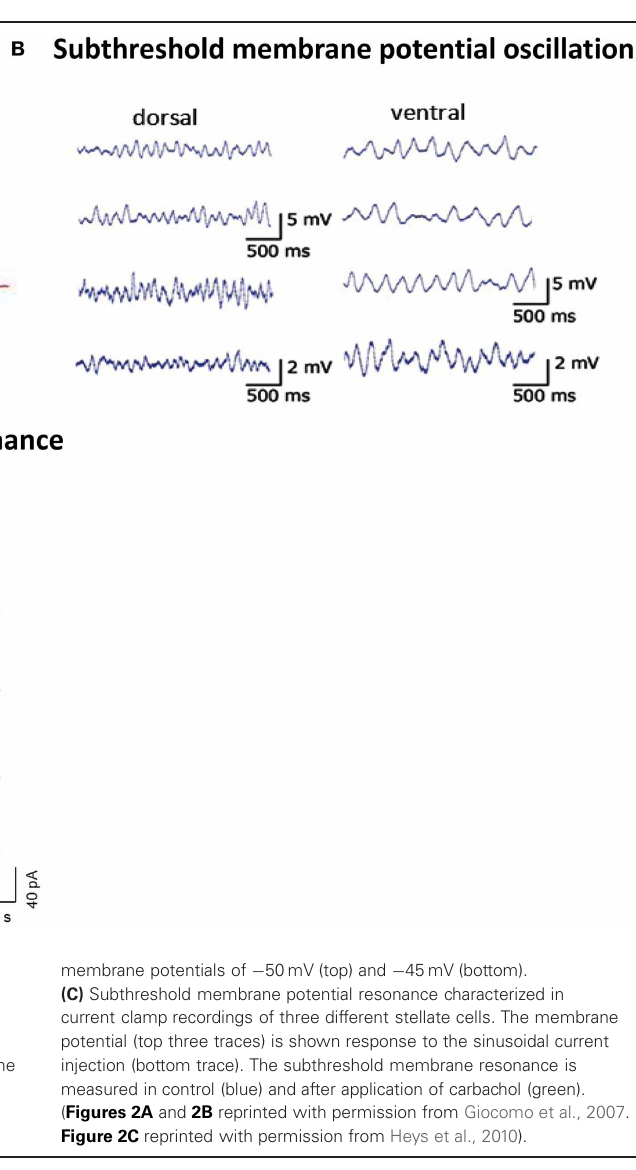
( Figure 2B , left) and 4 . 23 ± 0 . 32 Hz in ventral SCs at − 50 mV